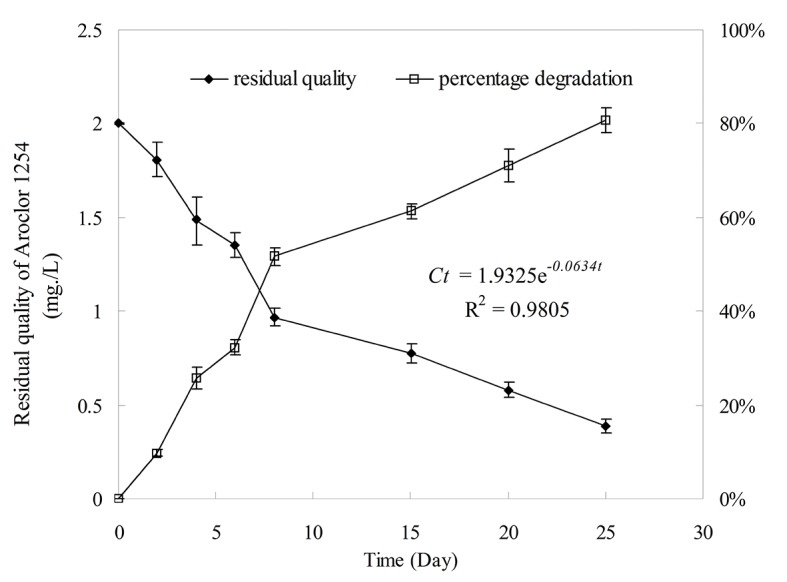
The biodegradation kinetics of Aroclor 1254 by Anabaena PD-1.The result was presented as the mean values±standard deviation (S.D.) of quadruplicate experiments.